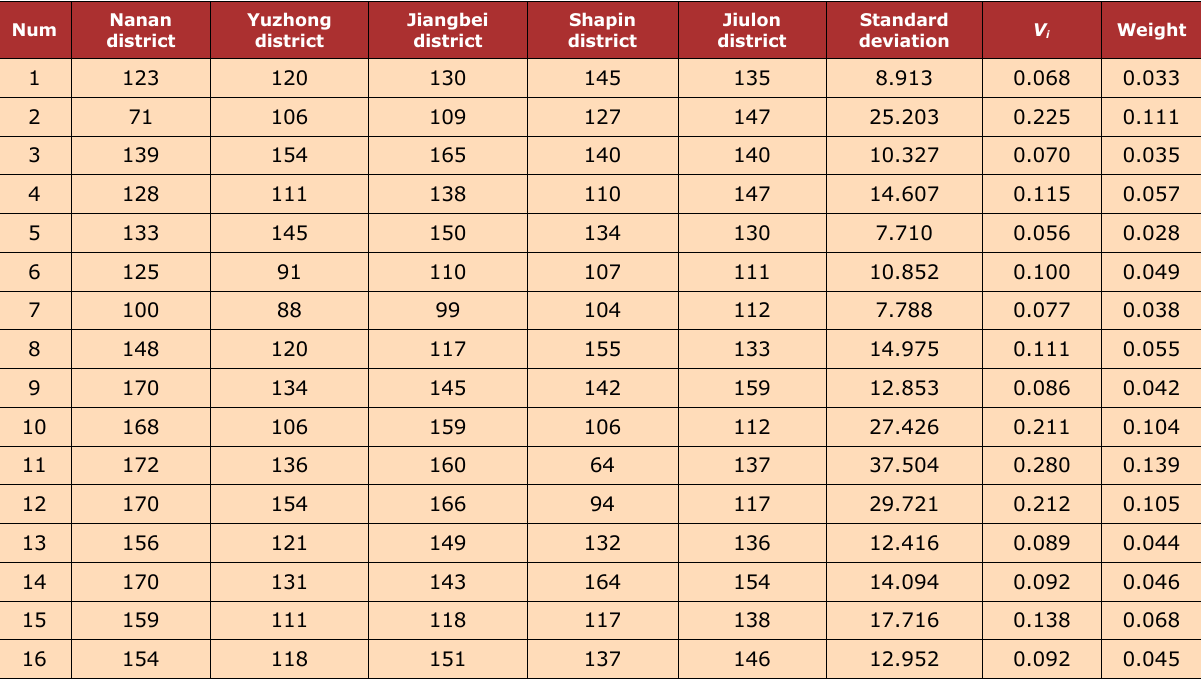
Table 2. Questionnaire data and calculation